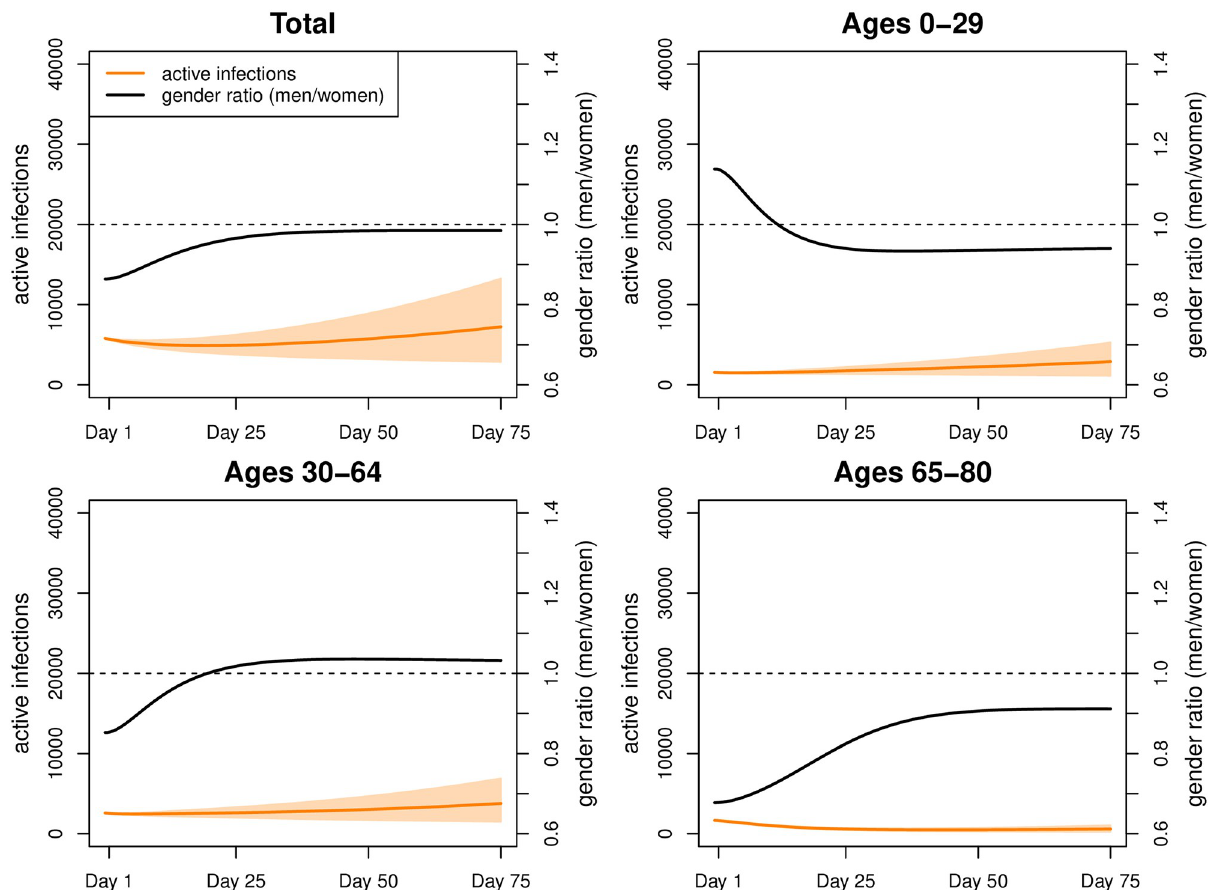
Fig 6. Simulation results for Scenario 1. Number of active infections and gender ratio (men/women) in Scenario 1 (intervals represent 80% range due to parameter uncertainty).